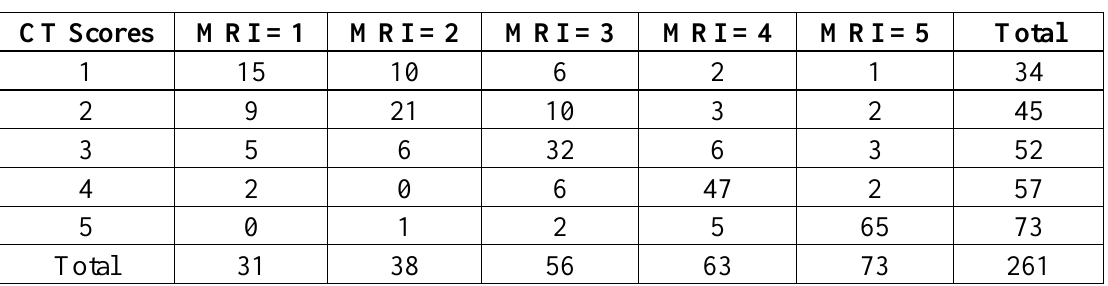
Table 27. (a) MRI and CT scores for diseased patients; (b) MRI and CT scores for non-diseased